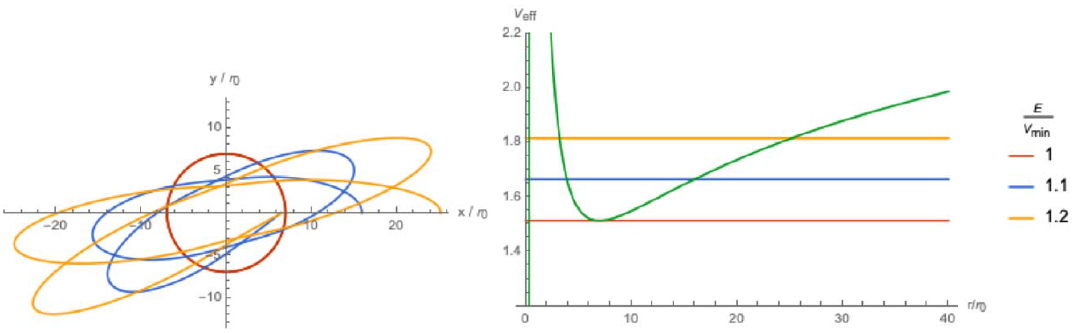
Figure 2 . Timelike geodesics obtained for the GR effective potential, where GM = 0 . 4 and L/r 0 = 3.